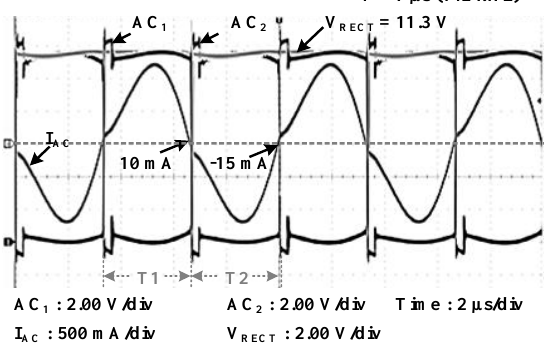
Figure 11. Measured waveform of the active rectifier.